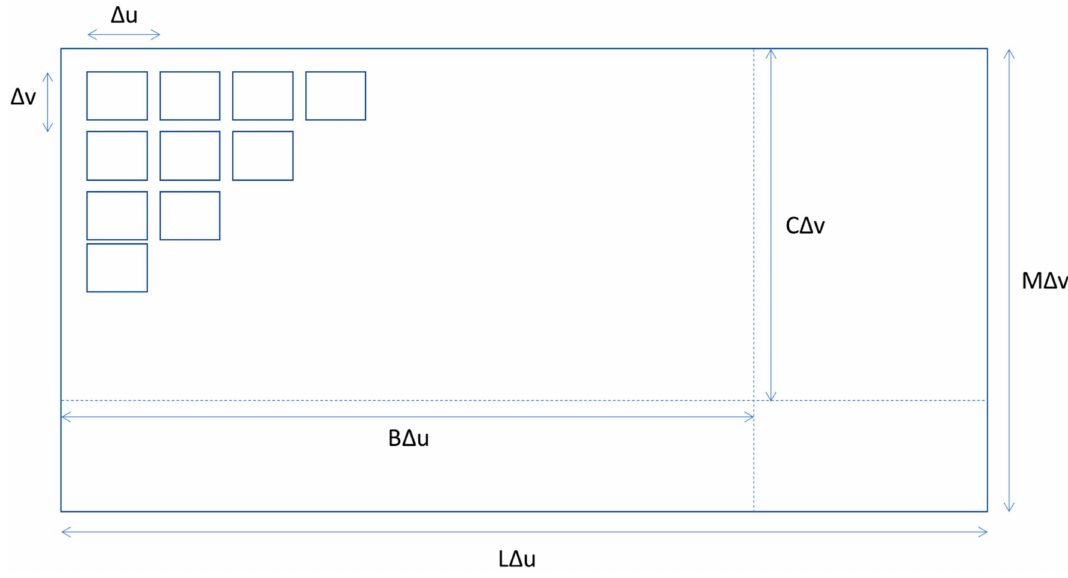
Figure 7. Pixel layout of